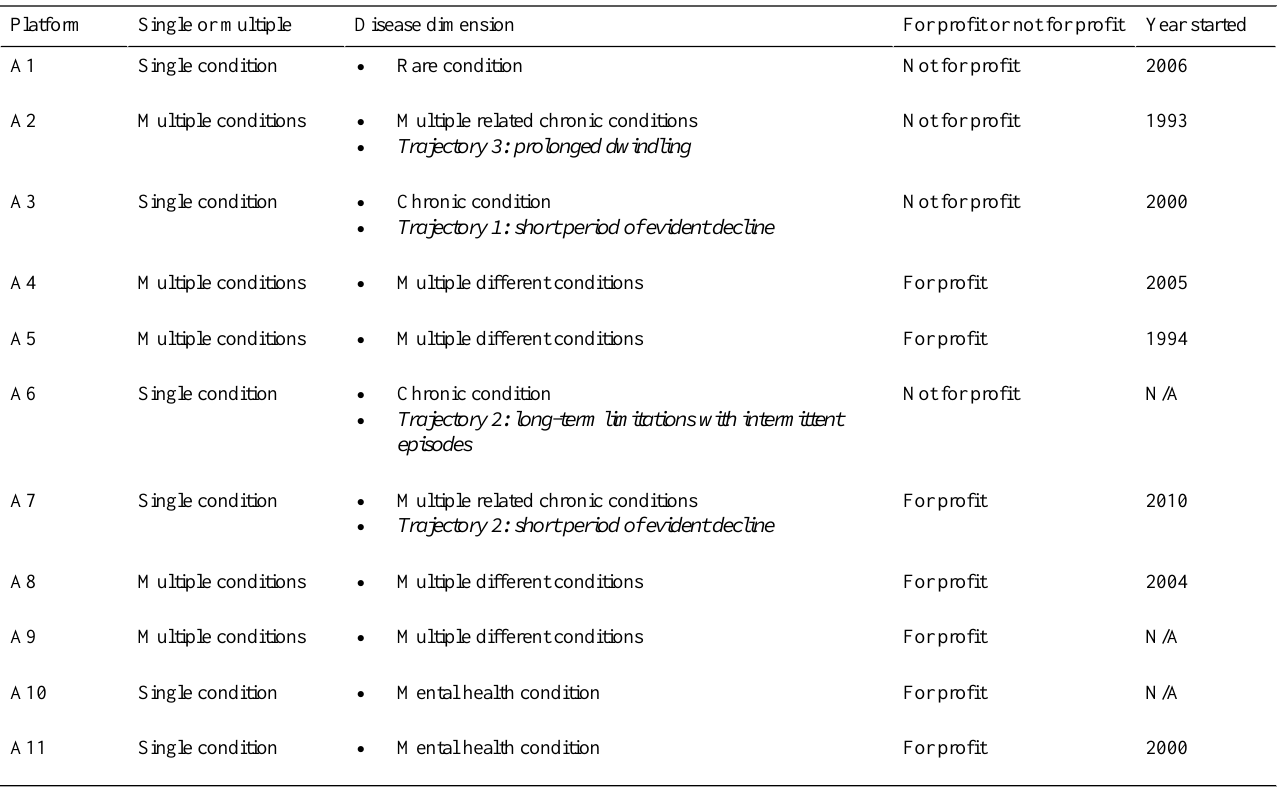
Table 2. Characteristics of the selected